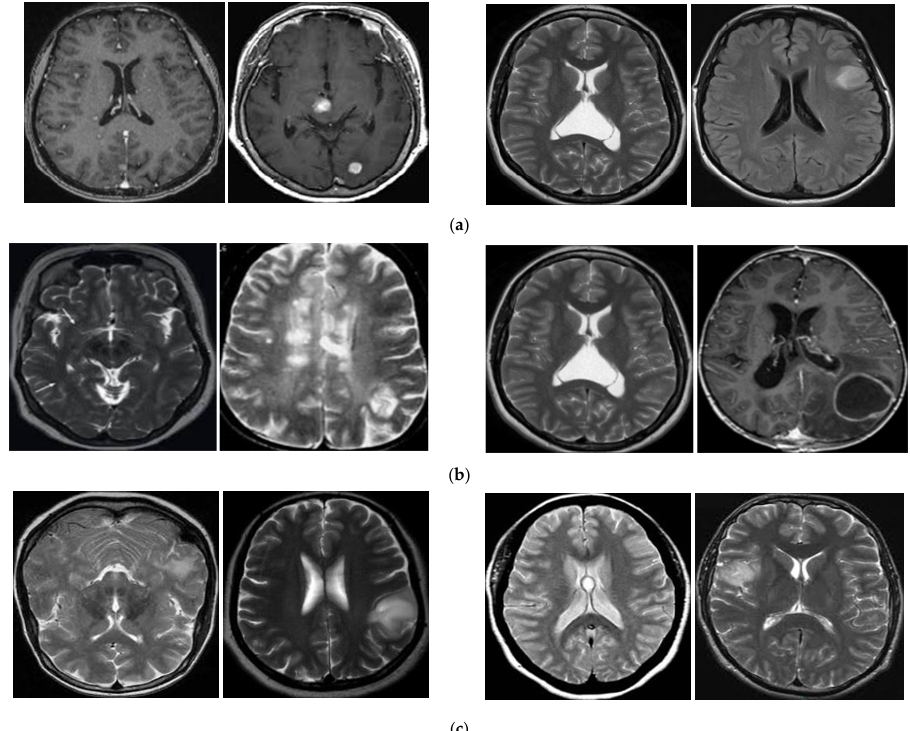
Figure 11. Examples of error cases of single classification methods: ( a ) SVM-based method, ( b ) MLP- based method, and ( c ) FS-based method. (Left pair: Non-tumor to tumor cases; Right pair: Tumor to non-tumor cases).